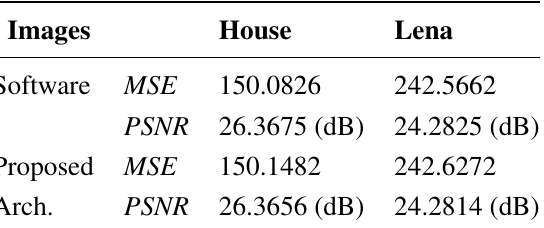
Table 10. Performance of the proposed architecture for image compression for N = 64 and dimensions w = 2 × 2